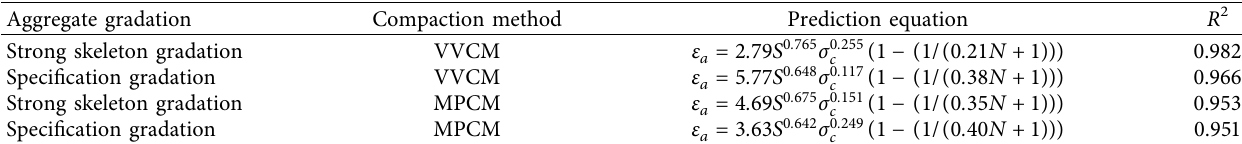
Table 5: Prediction